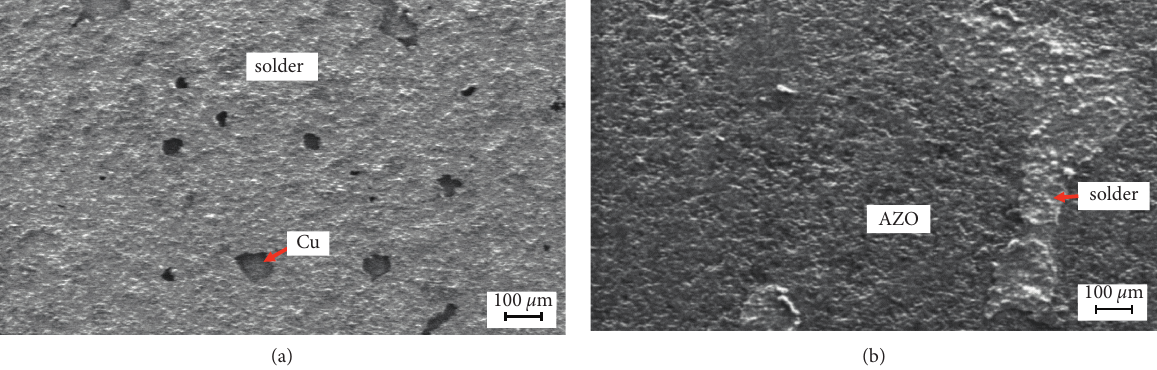
Figure 8: Fractography of an AZO/Cu joint with Sn